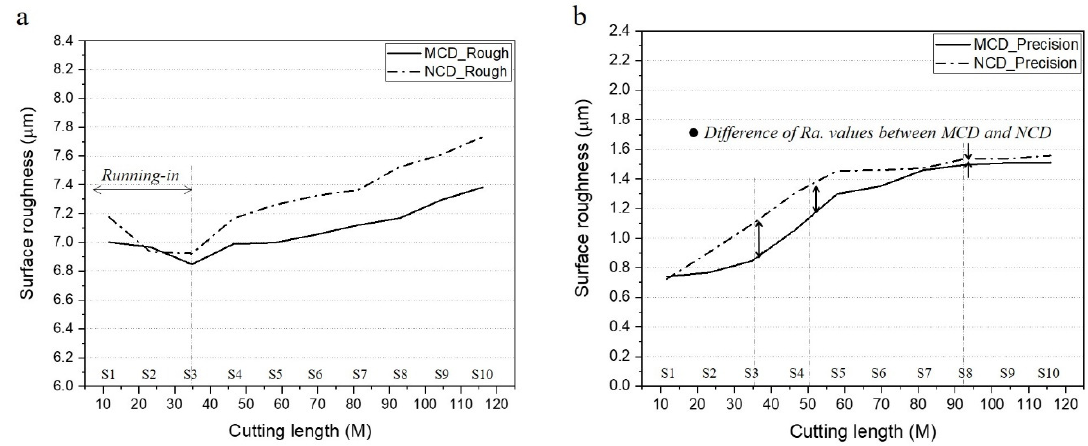
Figure 13. Roughness of machined surface according to cutting length for MCD and NCD-coated tools using ( a ) rough and ( b ) precision machining.